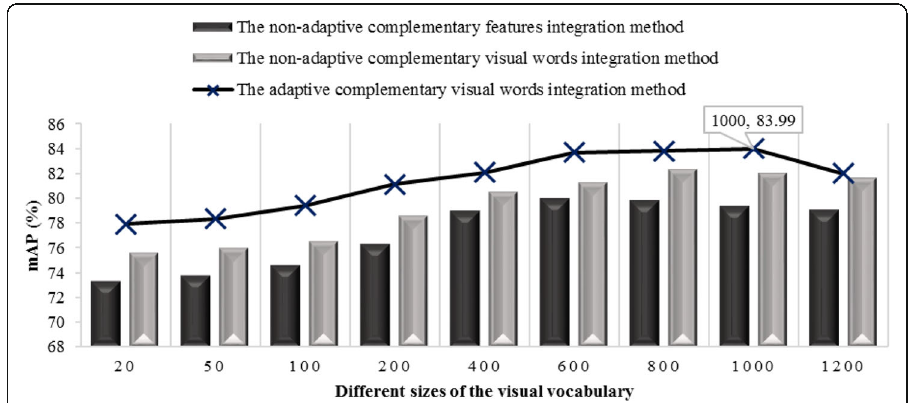
Fig. 10 Comparison of mAP of the proposed method with competitive CBIR methods on the Corel 1500 image